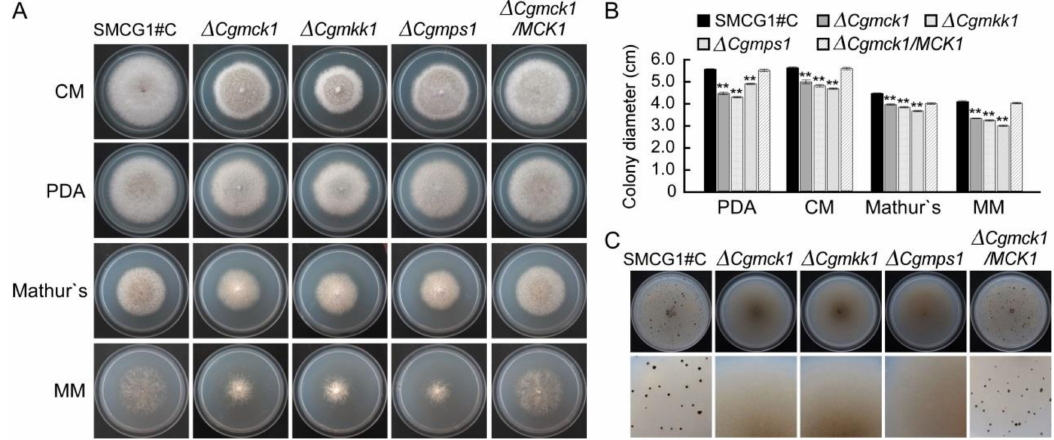
Figure 2. CgMck1 required for mycelia growth and fruiting body development. ( A ) Colony morphology of the wild type SMCG1#C, ∆ Cgmck1 , ∆ Cgmkk1 , ∆ Cgmps1 and the complemented strain ∆ Cgmck1 / MCK1 grown on complete medium (CM), potato dextrose agar (PDA), Mathur’s and minimal medium (MM) media for five days. ( B ) Colony diameter of SMCG1#C, ∆ Cgmck1 , ∆ Cgmkk1 , ∆